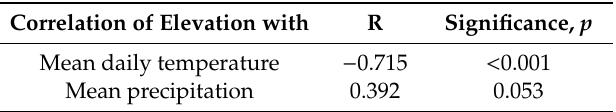
Table 2. Pearson correlation (R) between elevation and mean temperature and rainfall during the growing season across the 25 sites in Figure 1. Correlation of Elevation with R Significance, p Mean daily temperature − 0.715 < 0.001 Mean precipitation 0.392 0.053 p denotes statistical significance of the